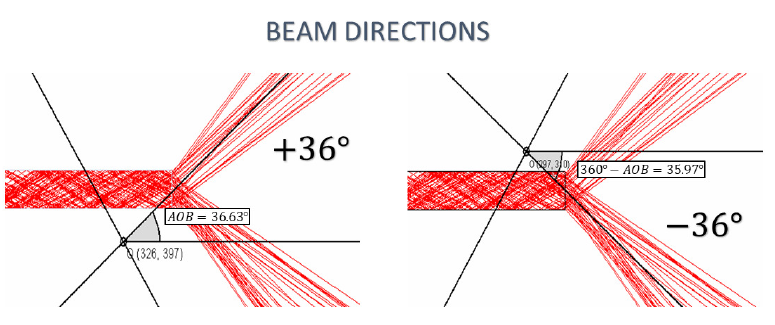
Figure 4. The two paths of the light beam after being bent by the µ MR . An angle of about 36 ◦ was identified with respect to the main direction of the